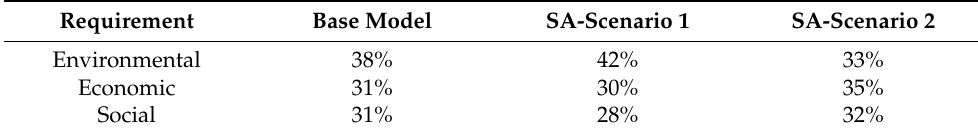
Table 3. Assigned weights for the base model and sensitivity